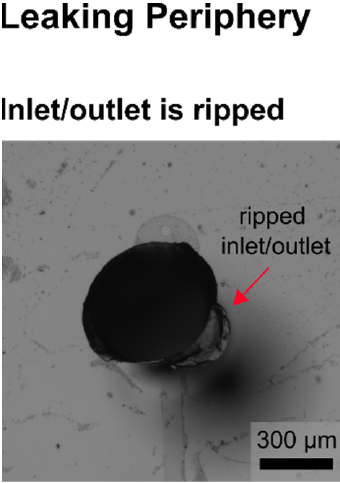
Figure A3. Example images of leaking periphery (see Table 4). Microscope image of Inlet/outlet is ripped.